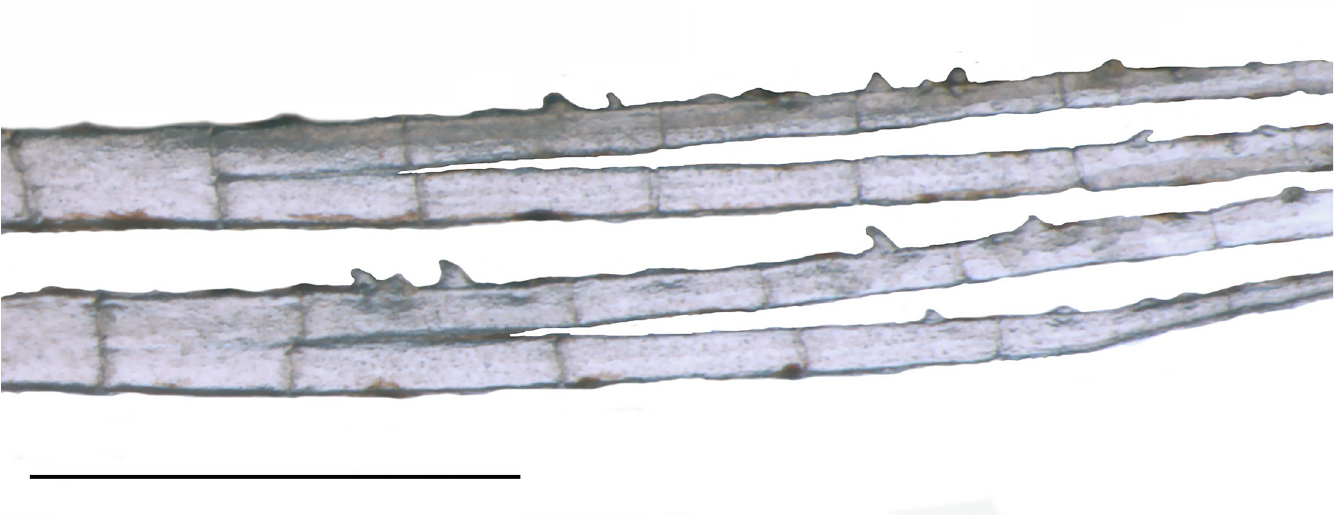
Fig 5. First two branched anal-fin rays of Tyttobrycon shibattai . MZUSP 125269, paratype, male, 16.5 mm SL, Lateral view. Scale bar 0.5 mm.